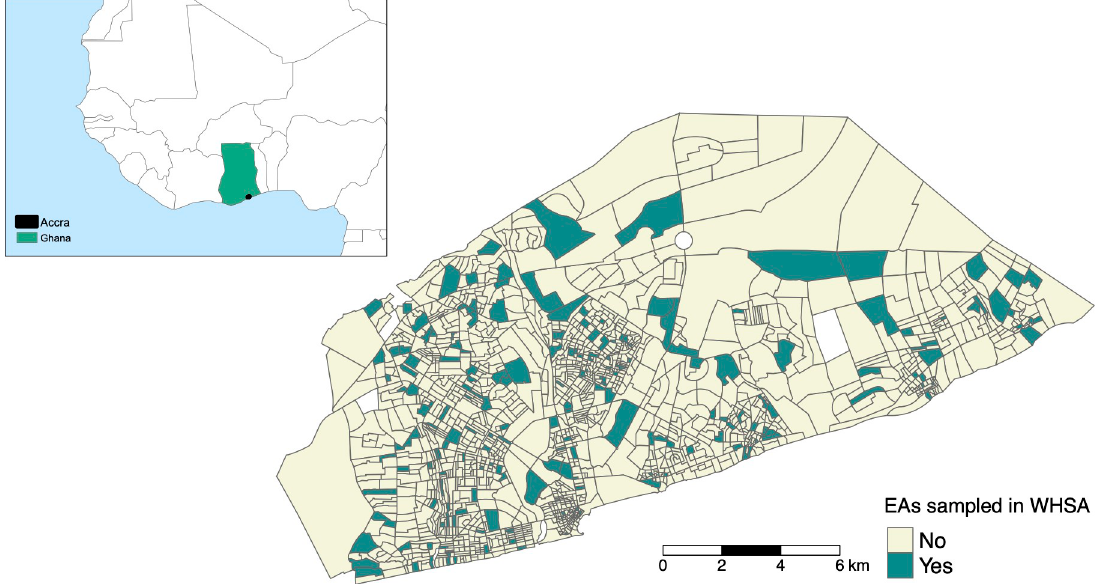
Fig 1. Census (year 2000) EAs where women were sampled for the WHSA (2008 to 2009) in the AMA, Ghana. Accra and EA boundaries are from the Ghana Statistical Service, and the background map of Africa and Ghana in the inset are made with Natural Earth vector map data: https://www.naturalearthdata.com/downloads/110m-cultural-vectors/. AMA, Accra Metropolitan Area; EA, enumeration area; WHSA, Women’s Health Study of Accra.